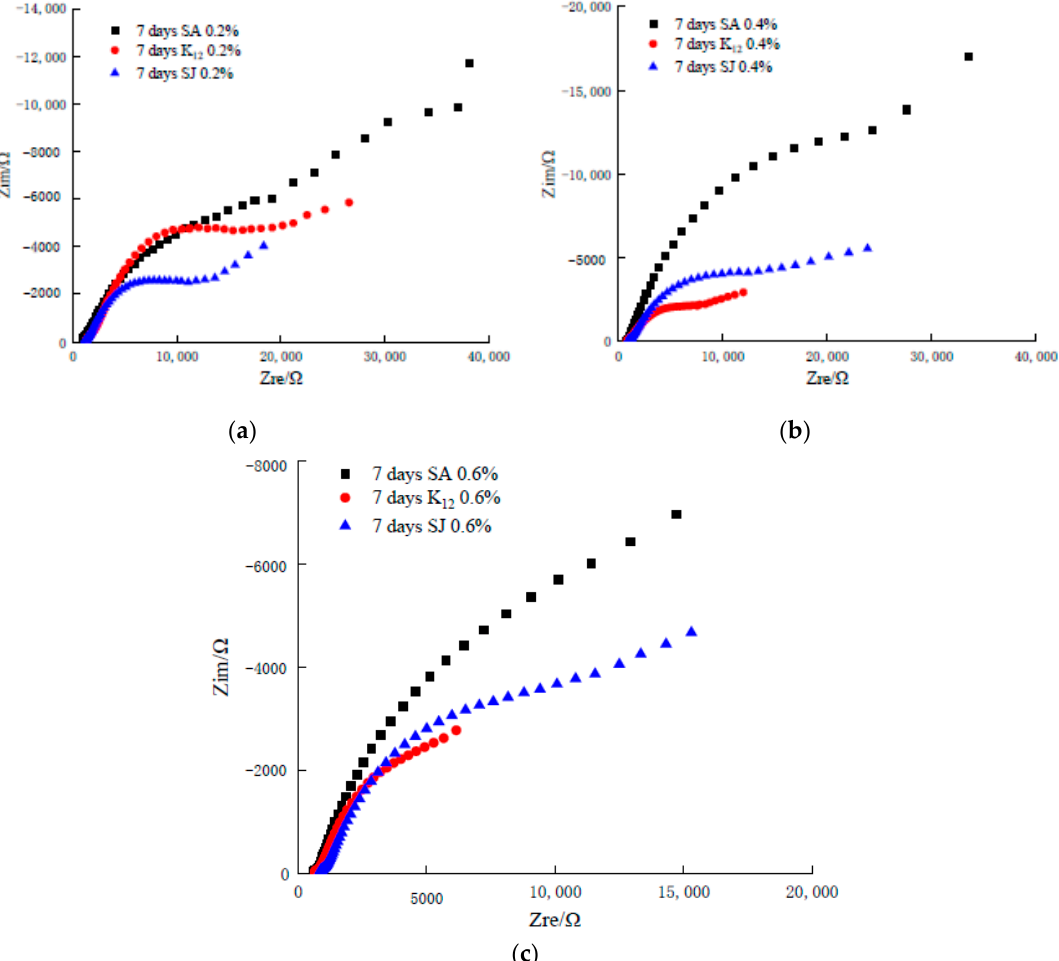
Figure 6. Nyquist diagram of the filling body with the same amount of AEA for 7 days of curing age. ( a ) Add 0.2% SA, K 12 and SJ, respectively; ( b ) Add 0.4% SA, K 12 and SJ, respectively; ( c ) Add 0.6% SA, K 12 and SJ, respectively.